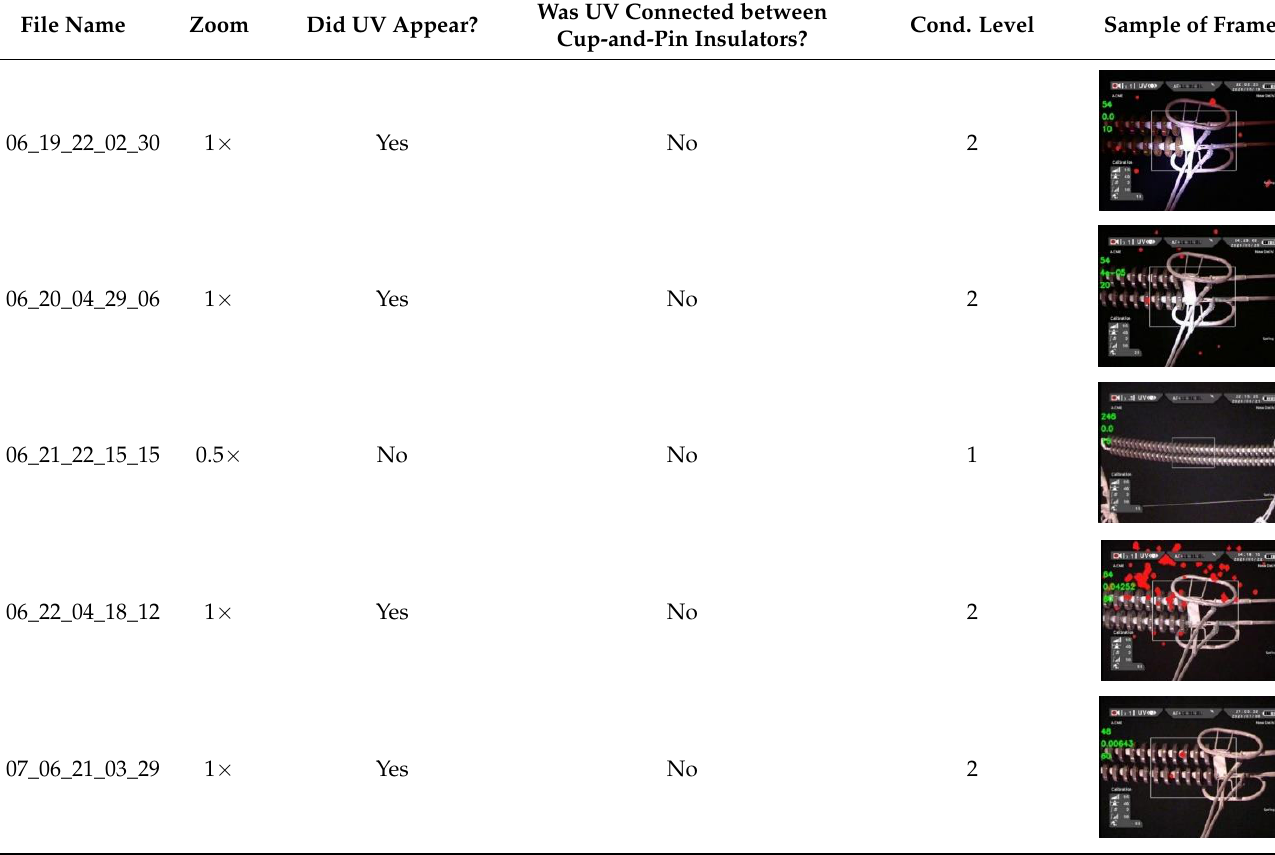
Table 4. Visual-based assessment results for T phase suspension string at the GT area.